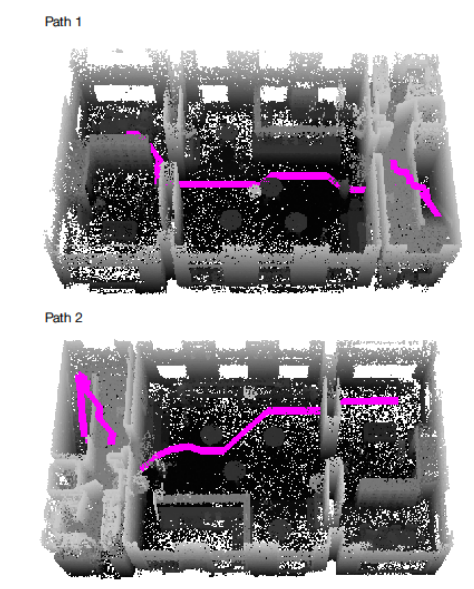
Figure 14: Pathfinding in the empty space of a point